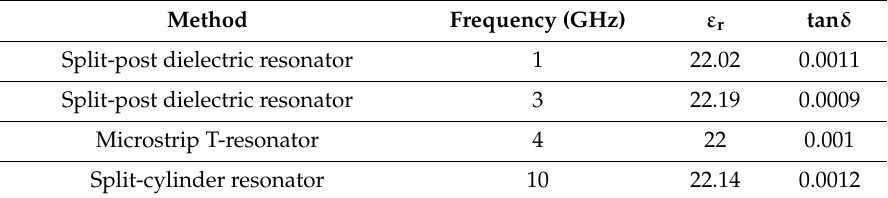
Figure 1. Electromagnetic characterization of the ENrG’s Thin E-Strate at 4 GHz: ( a ) Prototypes of the microstrip line and microstrip T-resonator; ( b ) measurement set-up for the S-parameters; ( c ) measurement results for the S21 parameter. Table 1. Electromagnetic characterization results for the ENrG’s Thin E-Strate with 40 µ m thickness at several frequencies using different methods.